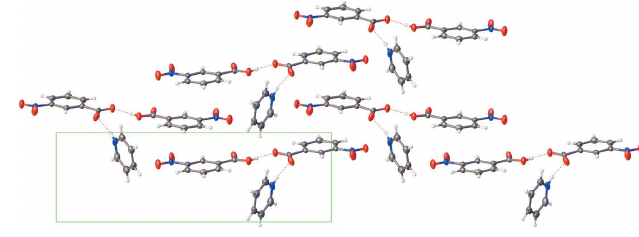
Figure 2 Packing diagram of the title compound viewed from the (100) face.